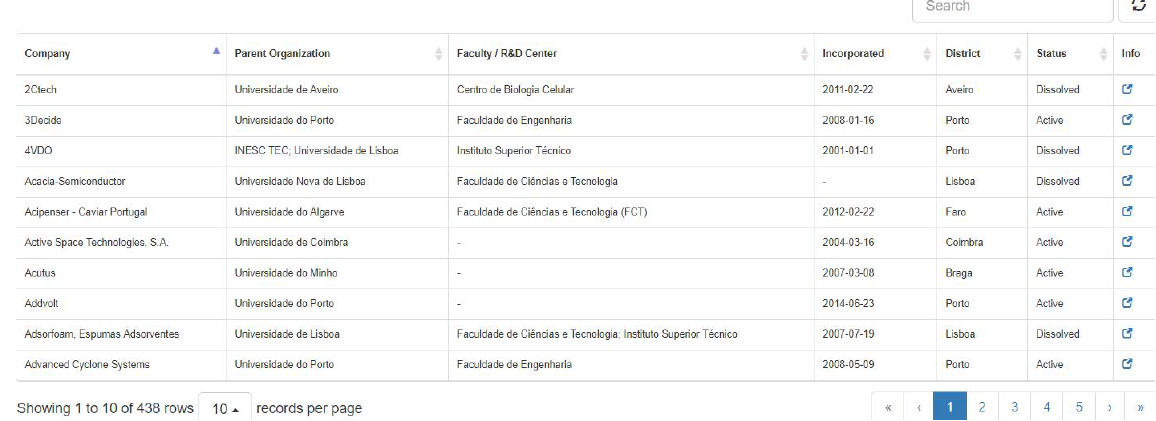
Fig. 1 Visualization of university